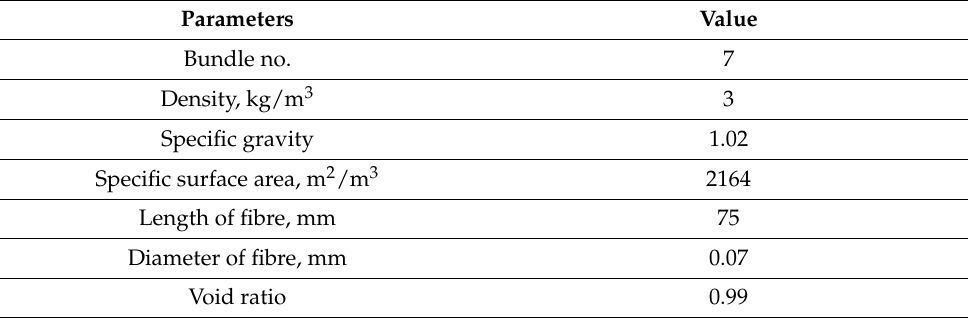
Table 2. Specifications of the flexible fibre used as packing media in the